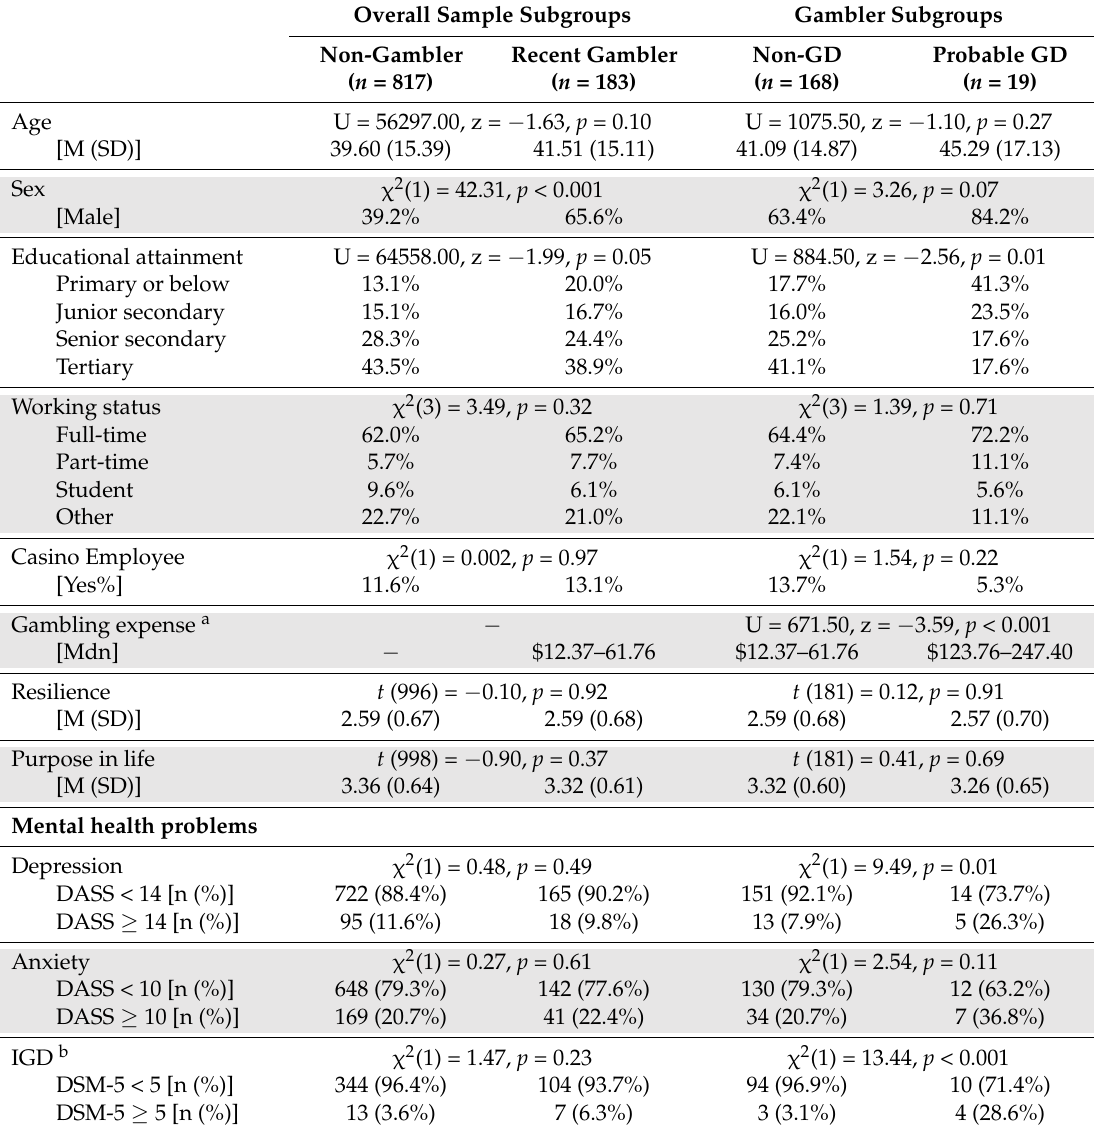
Table 1. Comparing Stratified Profiles of Overall Sample Subgroups and Gambler